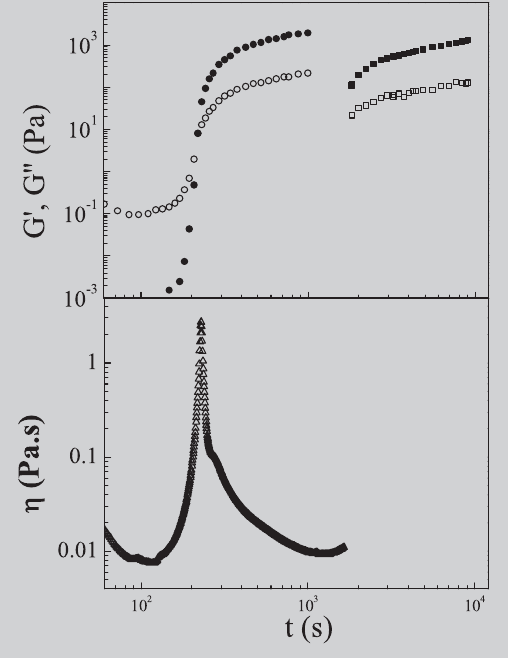
Figure 6 (left): Comparison of the time dependence of the storage ( Ê ) and loss ( Á ) shear mod- uli of an unperturbed sub- micelle solution at 120 g/L heated at 90ºC, with that of the same system (squares) after cessation of shear flow at t = 1.8·10 3 s. The viscosity during the period of shear flow at a constant shear stress of 20 Pa is shown in the bottom figure. Figure 7 (right above): Recovery of the storage shear modulus following the cessation of shear flow of a submicelle solution at 120 g/L heated at 80ºC dur- ing the shear flow. The tem- perature was lowered immediately after the shear flow was stopped to values indicated in the figure. For comparison the evolution of G' at 80ºC in the absence of shear flow is also shown (filled symbols). Figure 8 (right below): Time dependence of the vis- cosity for submicelle suspen- sions heated at 77ºC for different concentrations indicated in the figure. The shear rate was 10 s -1